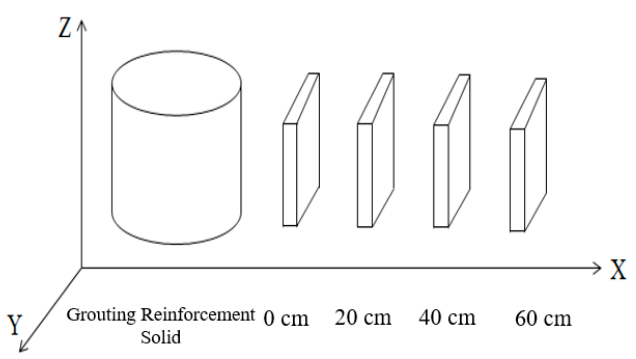
Figure 13. Location of cross-section sampling.